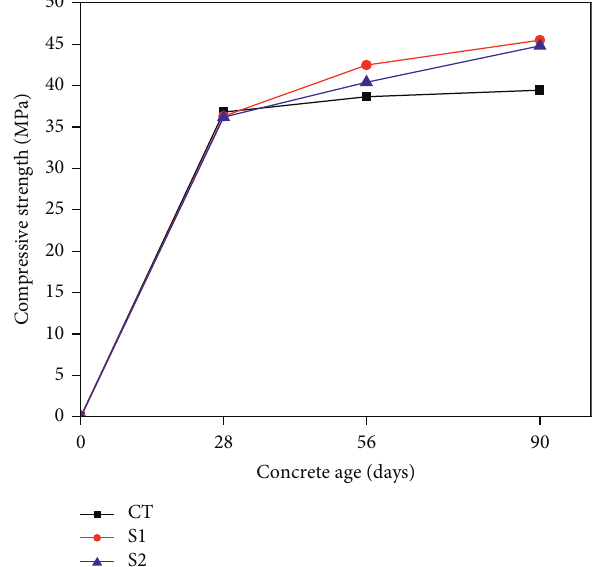
Figure 5: Compressive strength of CT, S1, and S2 immersed in potable water.